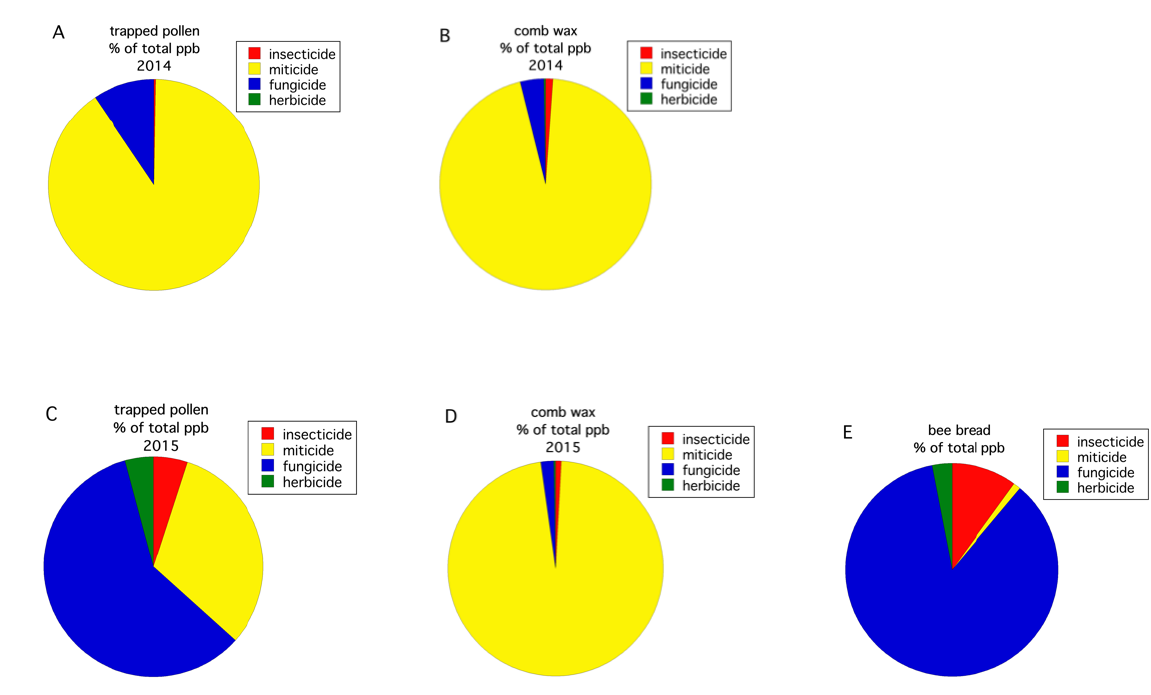
Figure 4. Percent composition of pesticide residue concentration (ppb) by use group in trapped pollen in 2014 ( A ), wax comb in 2014 ( B ), trapped pollen in 2015 ( C ), wax comb in 2015 ( D ), and bee bread in 2015 ( E ).